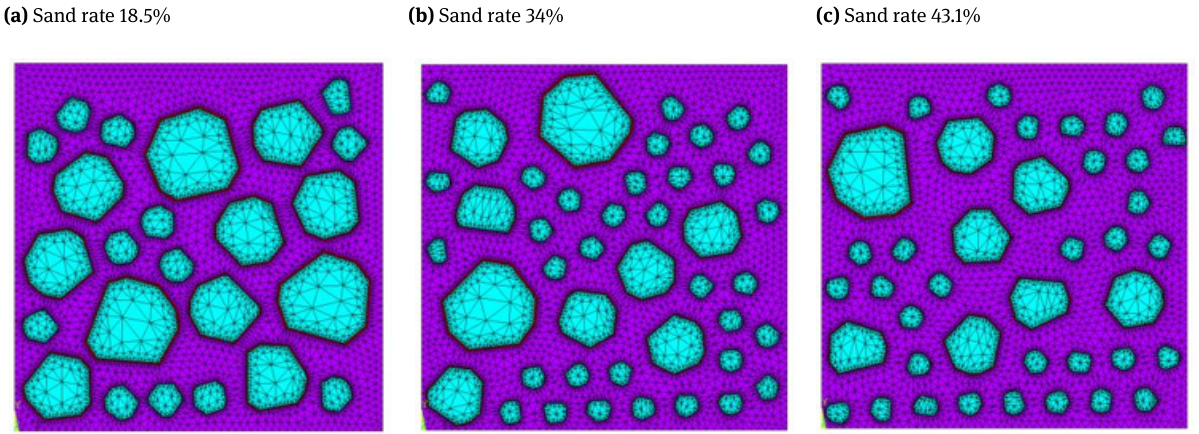
Figure 3: Random aggregate model